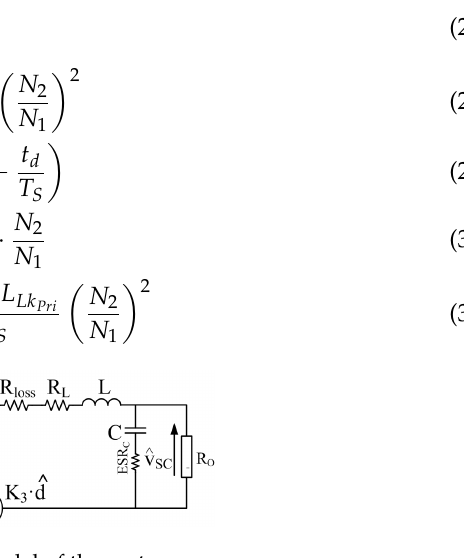
Figure 14. Full Small Signal Model of the